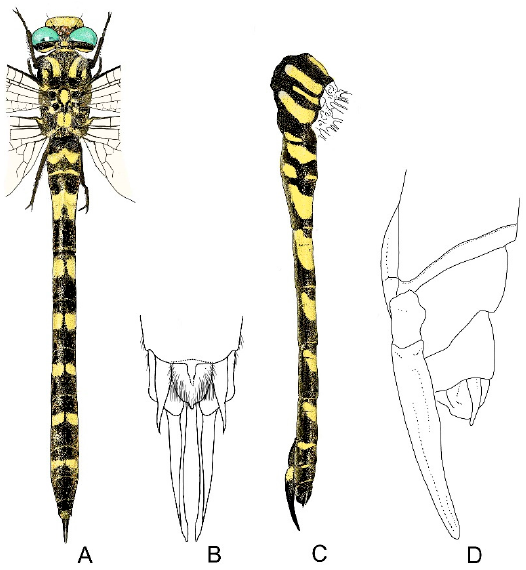
Figure 10. Cordulegaster kalkmani sp. nov., paratyp ♀ (RMNH, leg. Vincent Kalkman, 30.06.2003, RMNH.INS.747180, Turkey, Van, 8 km N Muradiye, near Bendimahi Selalesi, 39.0594° N 43.7540° E, 1850 m a.s.l.): ( A ): habitus, dorsal. ( B ): appendages, dorsal. ( C ): habitus, lateral. ( D ): appendages, lateral. Thorax (Figure 10A,C): colour pattern of prothorax and synthorax similar to male; in contrast to male yellow band at metepisternum not interrupted; metakatepisternum black with a pale yellow shadow near metastigma.